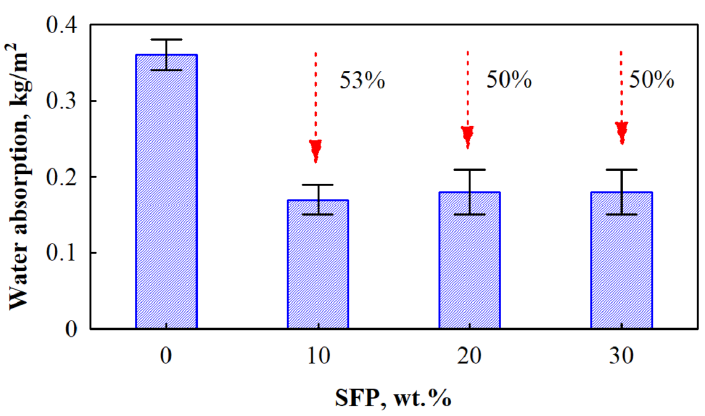
Figure 7. Short-term water absorption by partial immersion of SFP filler-modified PUR